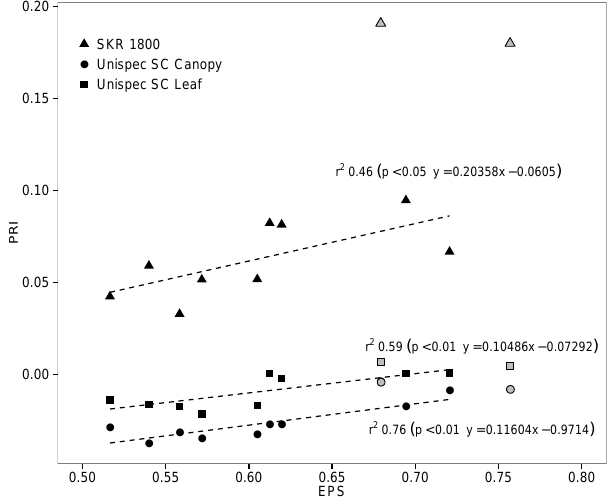
Figure 10. The photochemical reflectance index (PRI) as a func- tion of the epoxidation state of the xanthophyll cycle components (EPS) for a lodgepole pine ( Pinus contorta ) canopy and individ- ual leaves as measured by several different instruments. EPS and UniSpec SC leaf values are the means of the sampled plot corners ( n = 4 and n = 40; respectively), UniSpec SC canopy values are the mean of the PRI measurements collected coincident to the leaf- level measurements ( n = 3; collected over < 60s) and SKR 1800 values are single values corresponding to the same time period. Symbols shaded in grey represent measurements collected at a time when the solar zenith angle was > 60 ◦ and have been excluded from the regressions, for both canopy and leaf-level measurements. Data shown have not been normalized to correct for the SRF differences between